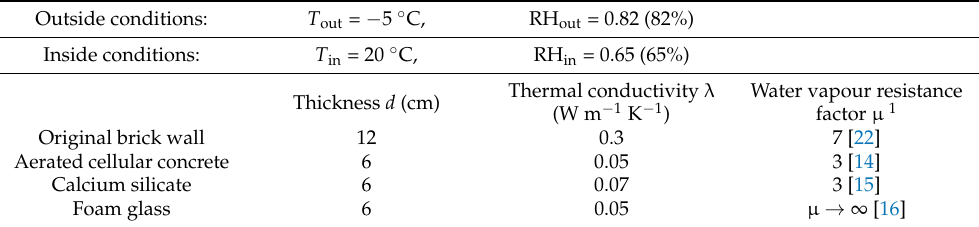
Table 2. Material properties and dimensions of four walls used in the calculations.